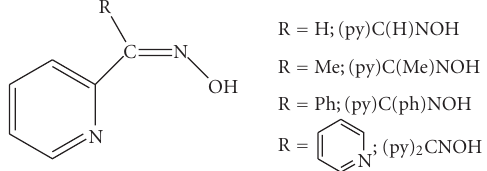
Scheme 1: General structural formula and abbreviations of sim- ple 2-pyridyl oximes, including methyl(2-pyridyl)ketone oxime [(py)C(Me)NOH].